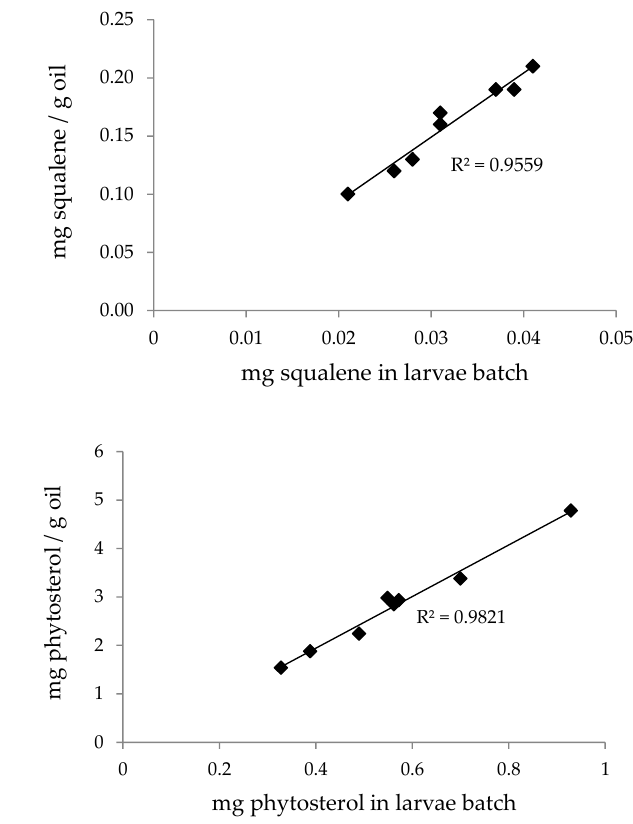
Figure 5. Squalene ( a ) and phytosterol ( b ) content (mg/g) in the extracted oils from the different H. illucens batches as a function of their content (mg) in the larvae sample. Extraction conditions (1350 cm 3 vessel): 450 bar, 60 °C, 450 g larvae batch, 130 g/min CO 2 , and 190 min. Moisture values were in the range of 0.118 – 1.706% w/w. Currently, there is a lack of specific recommendations or standards for moisture content of oils from edible insects.